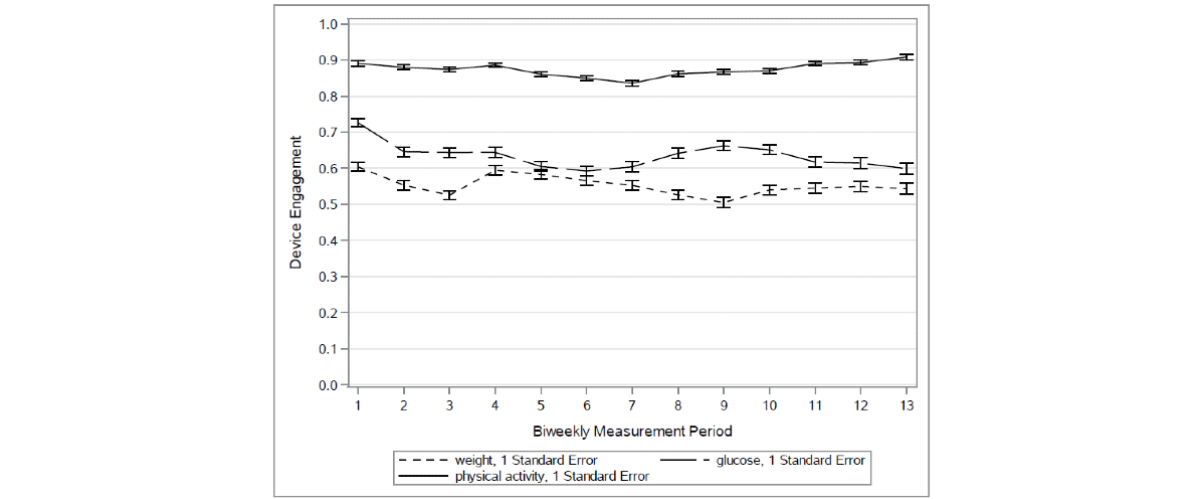
Figure 1. Empirical plots (mean, SEM) for biweekly engagement trajectories for each mobile health device over all 6